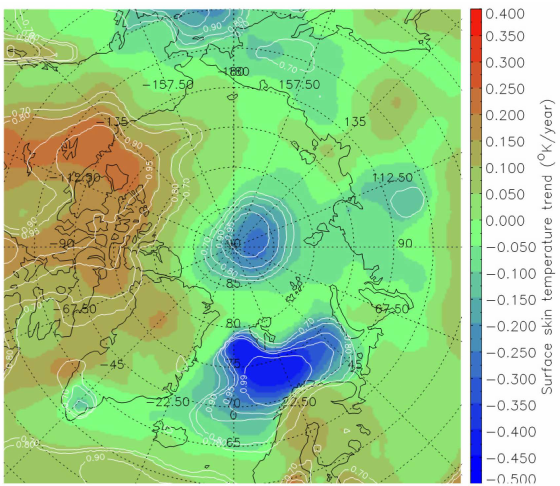
Figure 11. Surface skin temperature trend over the Arctic Ocean in winter, 1982–1999. The North Pole is at the center of the image; Greenland is in the lower left. The colors represent the trend in Kelvin per year. Contours show the statistical level of confidence of the trend. Areas with cooling trends are indicated with